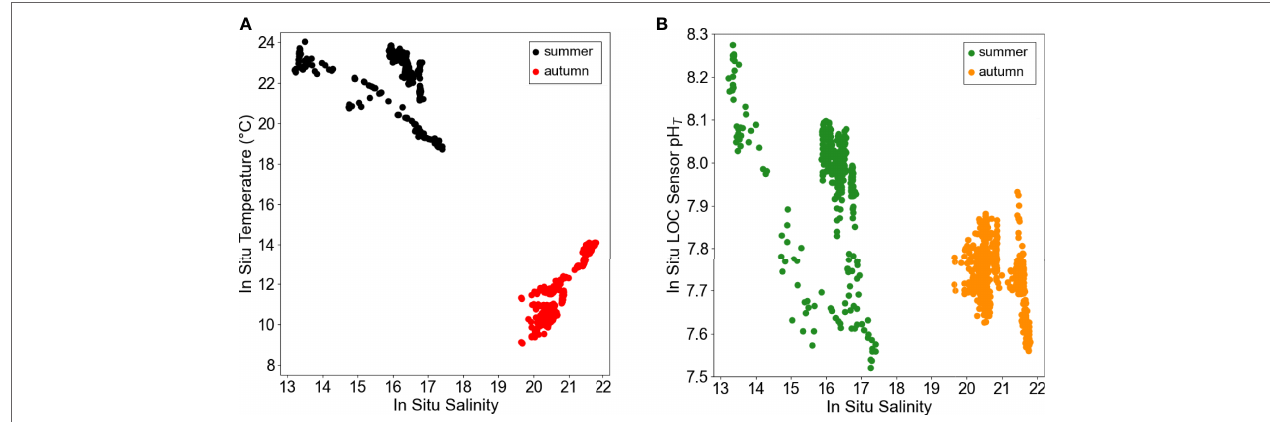
FIGURE 6 | In situ (A) temperature-salinity and (B) pH T -salinity diagram of the period investigated, illustrating different hydrological periods in summer (black, green circles) and autumn (red, orange